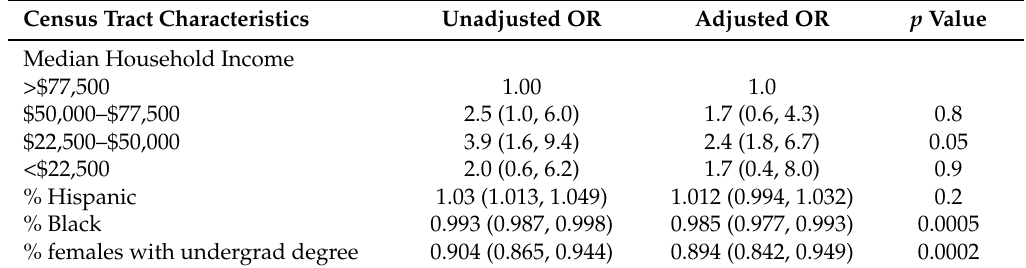
Table 4. Multivariate model results explaining TRI facility presence. OR: odds ratio.